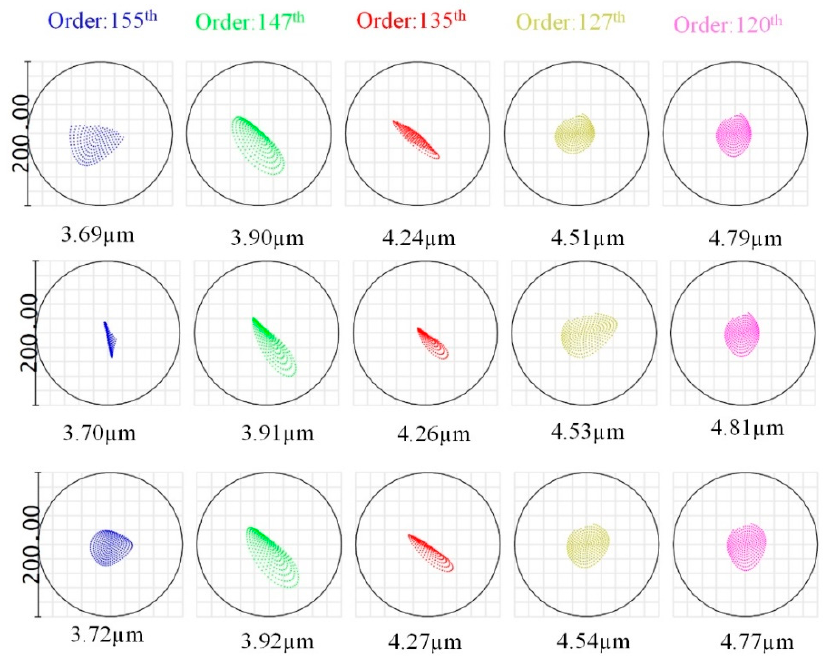
Figure 12. Spot diagrams of three wavelength points with uniform distribution for each order.